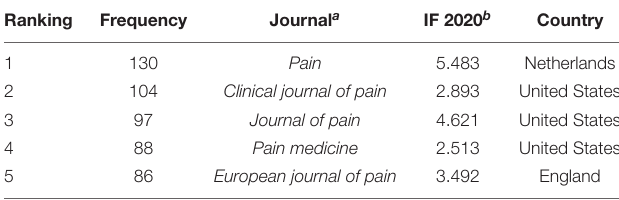
TABLE 1 | The top five journals with the highest frequency of pain